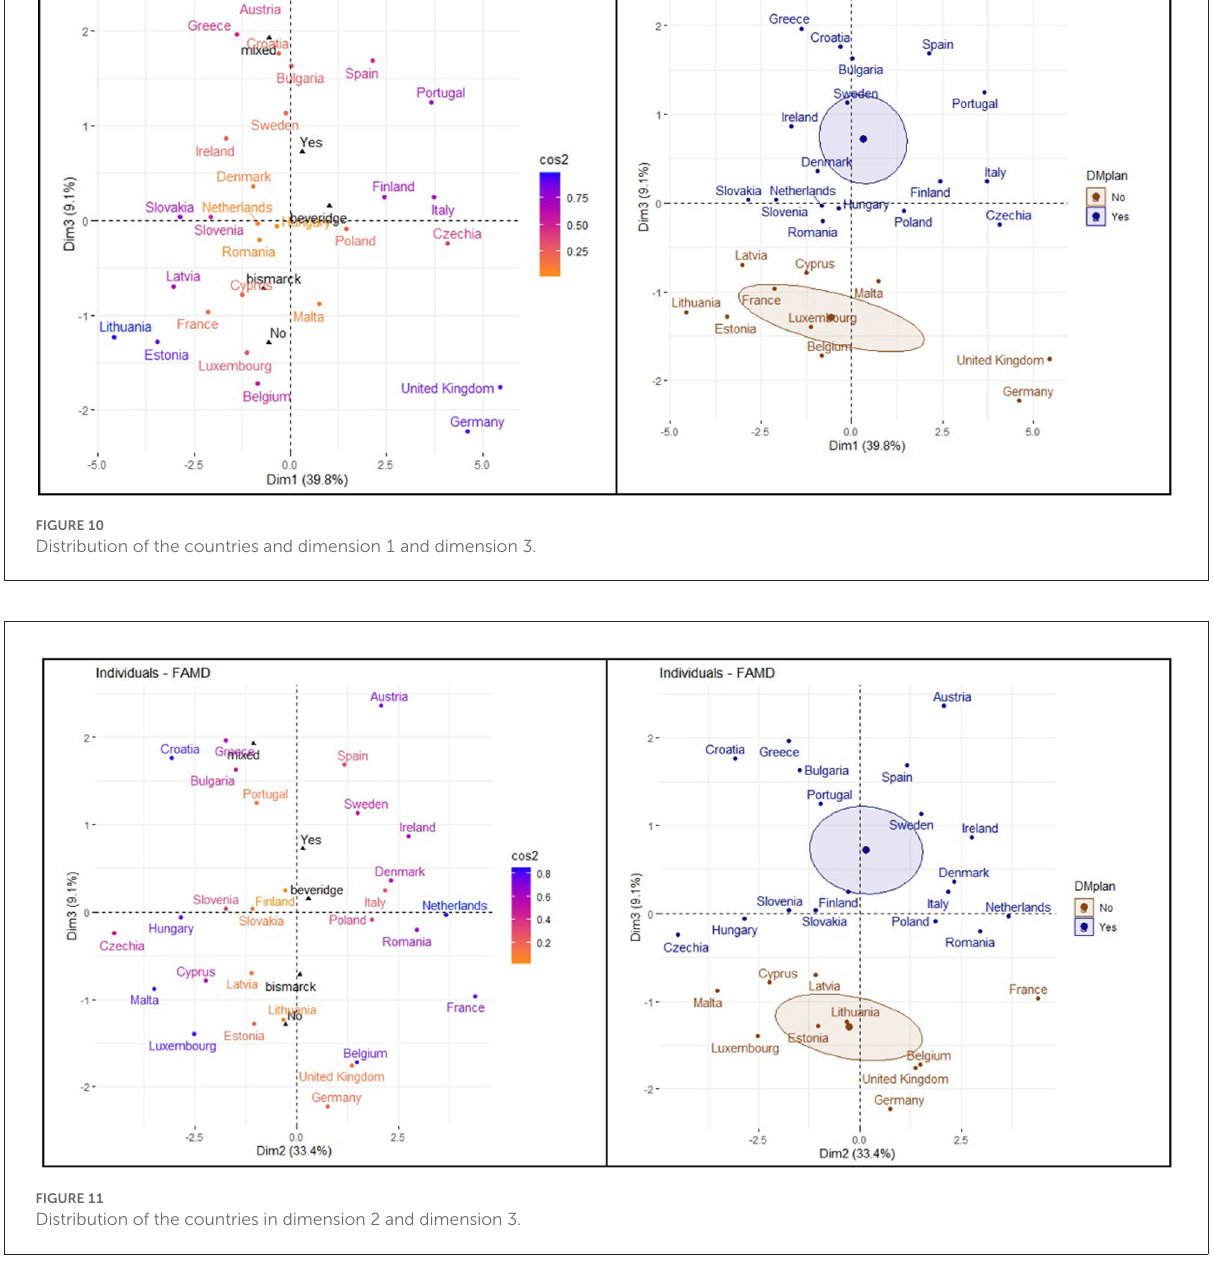
countries with NHPs and higher prevalence of DM, many changes in internet search trends happened on WDMD. The Figure 11 factor map is generated from dimension 2 and 3. Among countries with NHPs, higher searches for RSV imply a higher number of times of noticeable changes in internet searches on DM during the